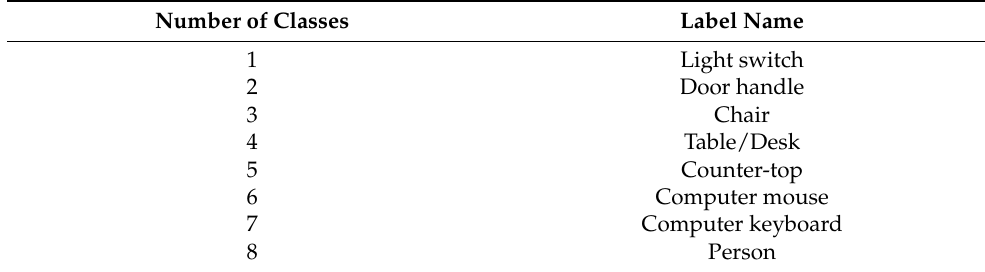
Table 1. List of image classes used in this